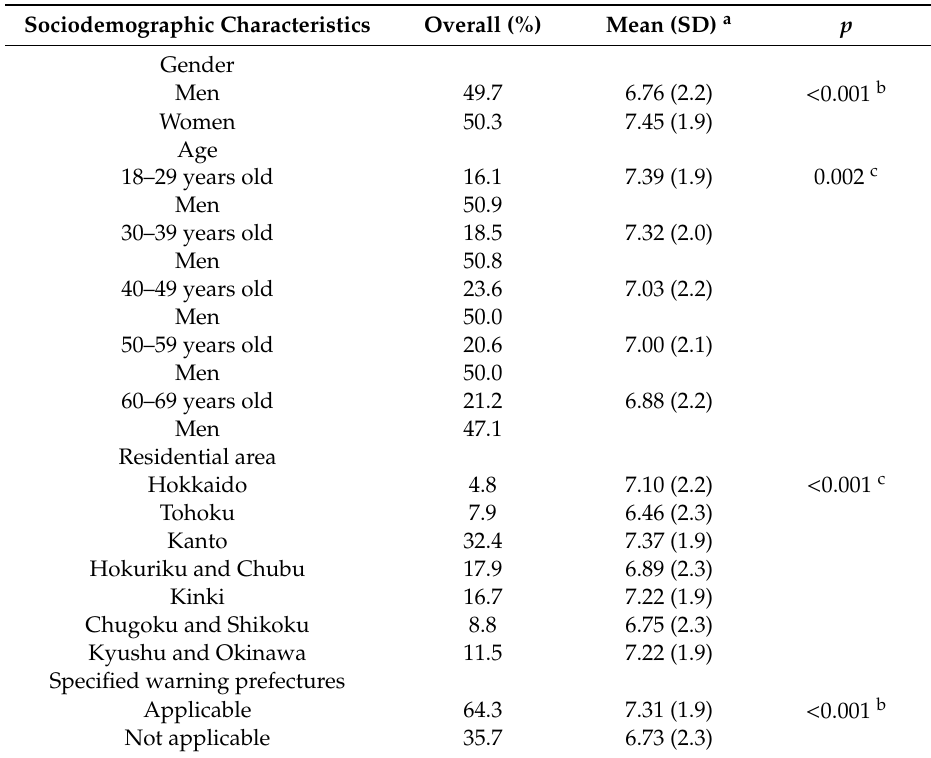
Table 1. Sociodemographic characteristics of the participants and their associations with staying at home ( n =